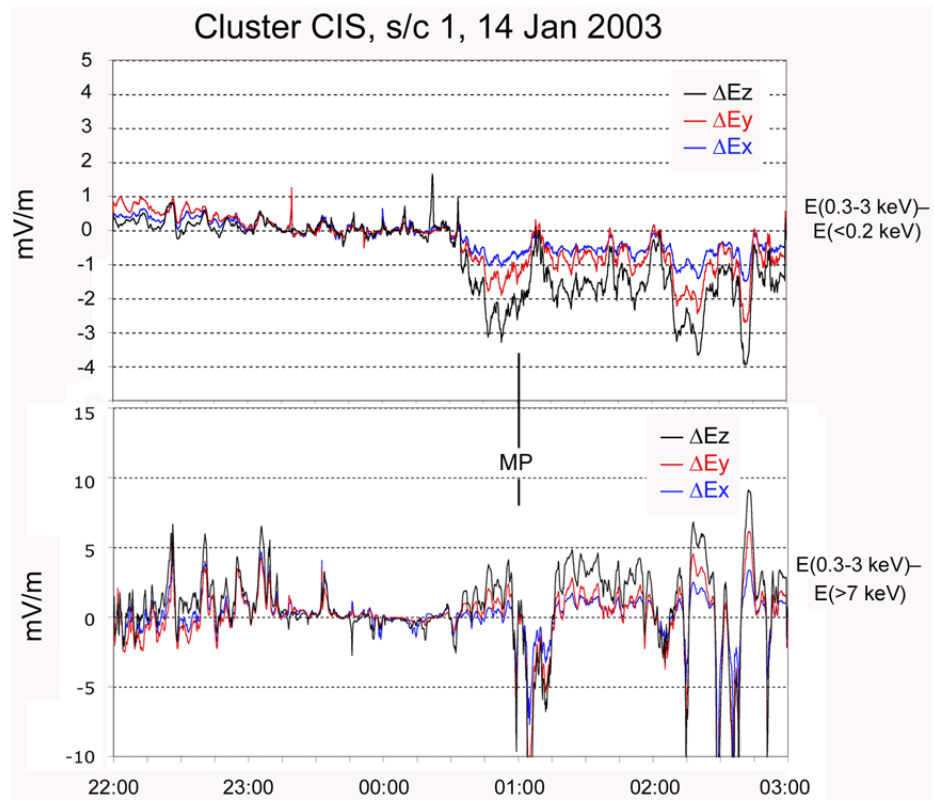
Fig. 5. Cluster s/c 1 ion data on 14 January 2003 of the difference in − v × B between 0.3–3keV and < 0.2keV (E 2 –E 1 ) , and between 0.3–3keV and > 7keV (E 2 –E 3 ) , respectively. The magnetopause traversal is marked by